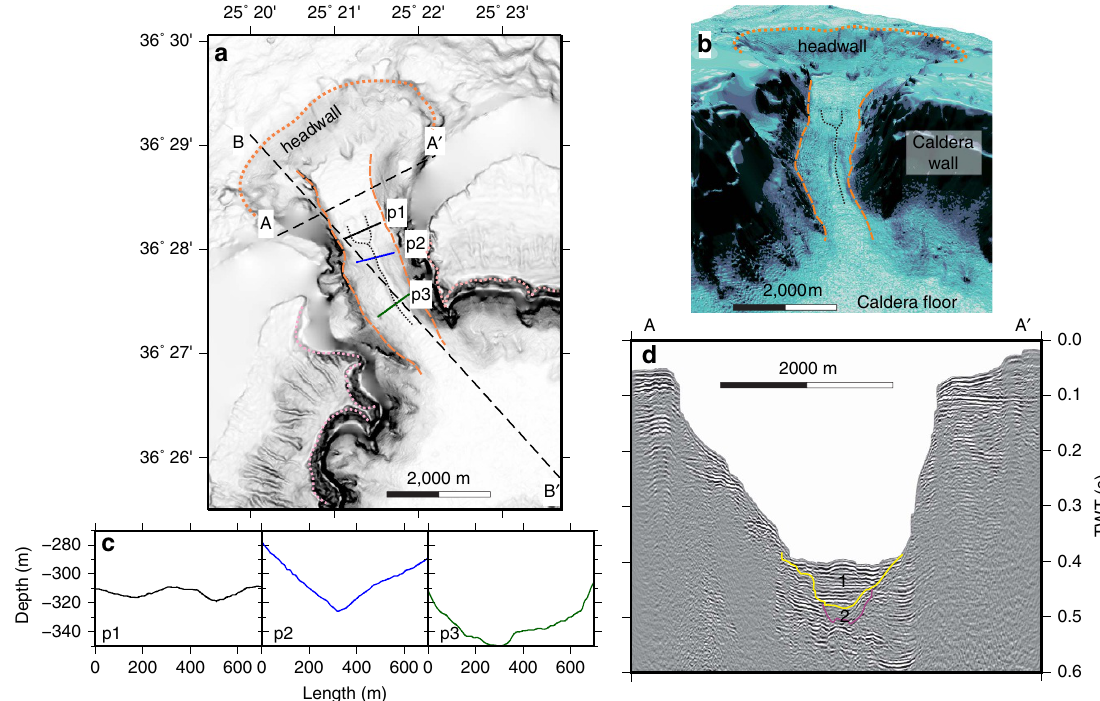
Figure 2 | More detailed topography and seismic profiling of the NW strait of Santorini caldera. ( a ) Shaded slope gradient with the location of profiles shown in 2c (p1, p2 and p3), 2d (seismic profile A-A 0 ) and Fig. 3 (seismic profile B-B 0 ) marked. The dotted orange line marks the location of the erosional headwall, the dashed orange line the channel sides, the dotted pink line the rim of the caldera, and the dotted black line the small-scale drainages superimposed on the large-scale channel. ( b ) Perspective view of the NW strait. ( c ) Bathymetric cross sections perpendicular to the NW strait. ( d ) Seismic profile perpendicular to the strait axis, showing caldera-fill stratigraphic units 1 and 2 of ref. 10.